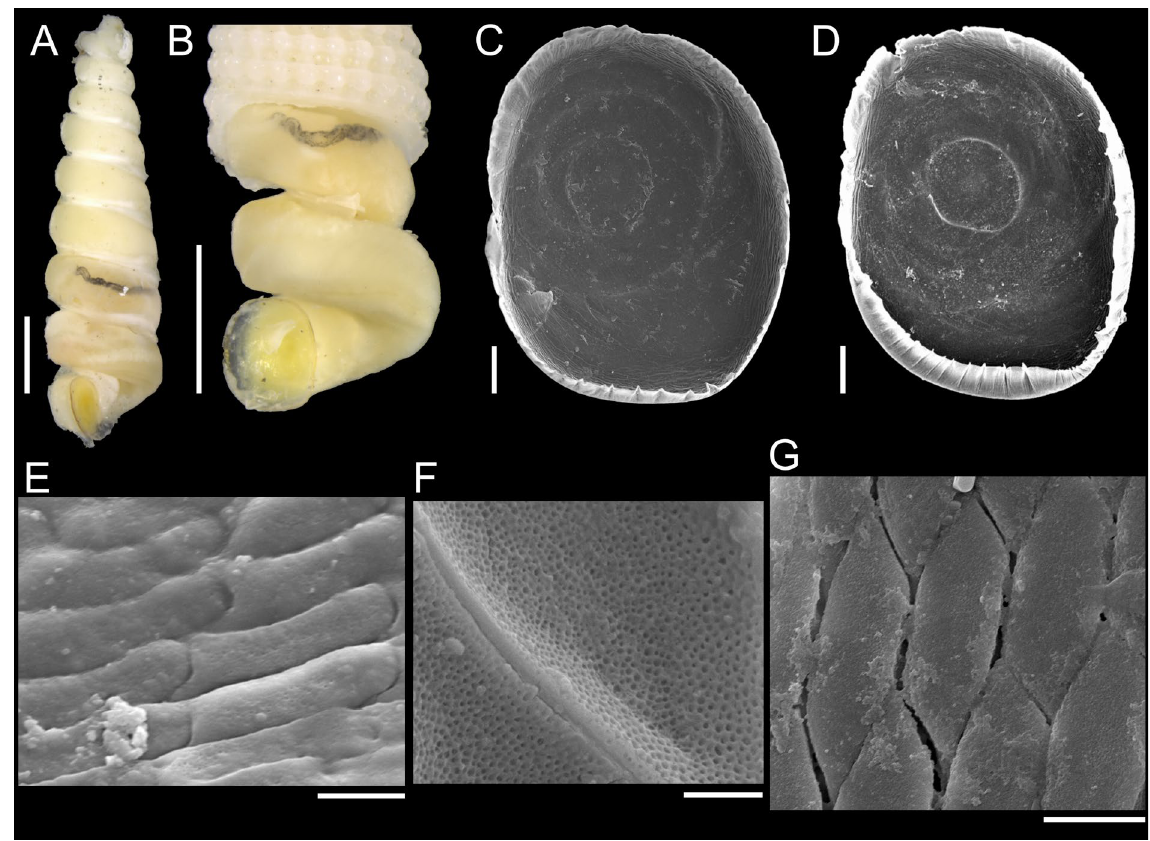
Fig. 7. Cosmotriphora melanura (C.B. Adams, 1850). A, E, G . MNRJ 33138. B–D, F . MNRJ 18750. A–B . External morphology, different specimens. C–D . Operculum. E–G . Jaw, outer (E–F) and inner (G) sides. Scale bars: A–B = 1 mm; C–D = 100 µm; E, G = 5 µm; F = 2